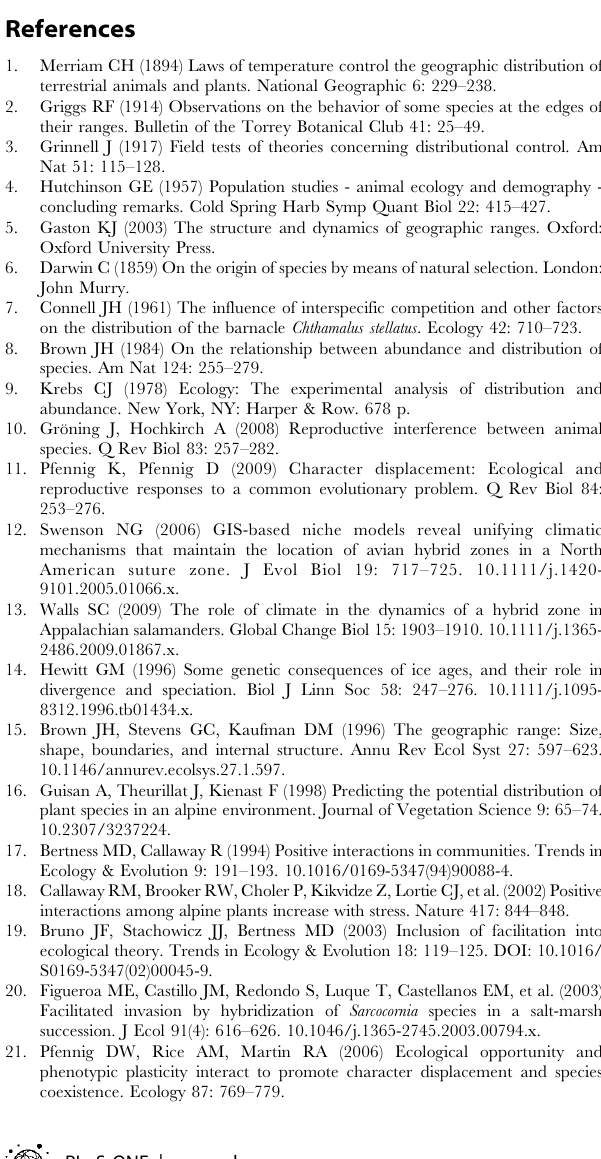
Table S4 Mean and standard deviation for each of the four niche models run for the sensitivity